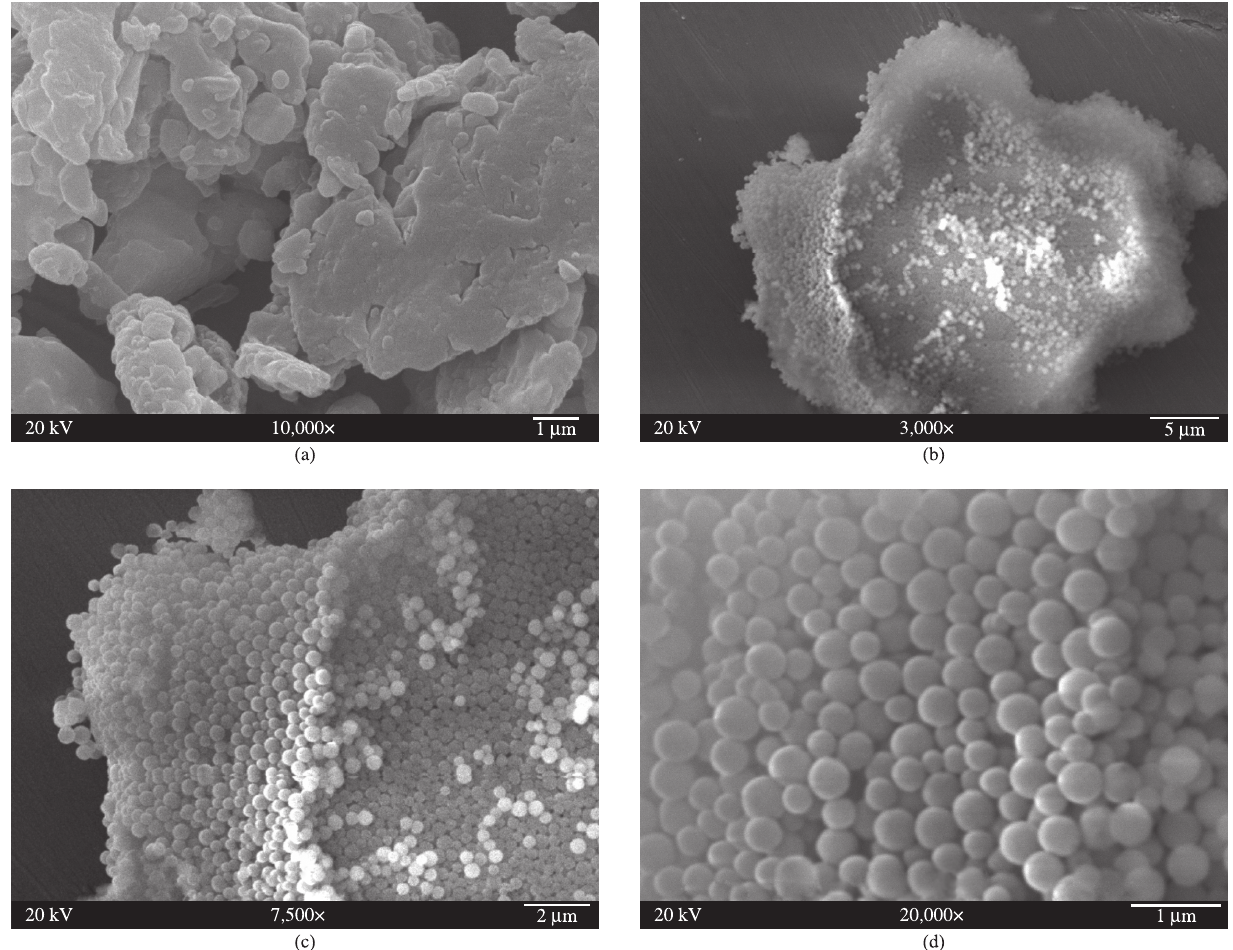
Figure 2. Scanning electron micrographs at different magnifications of sample B2-PEG: a) 10000× b) 3000× c) 7500× d) and